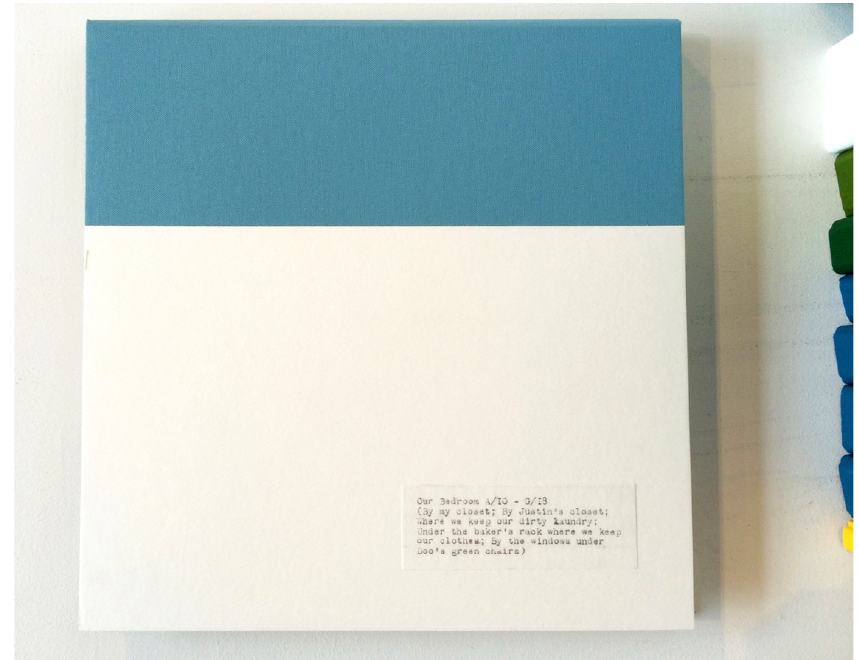
Figure 4. The floor we walk on , 2015. Enjoy Public Art Gallery, Te Whanganui-a-tara. Installation detail of Something Felt, Something Shared , curated by Emma Ng. Graphite on paper, dimensions variable. Photo: Andrew Matautia. Collection of Chris Parkin.